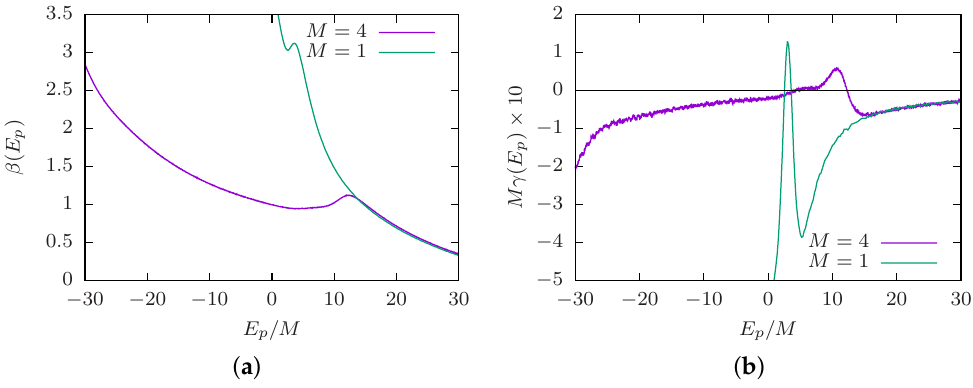
Figure 7. Microcanonical illustration of the competition between single-polymer collapse and many-polymer aggregation on the example of M semiflexible bead-spring polymers ( κ = 4, N = 13) showing ( a ) the microcanonical inverse temperature β ( E p ) and ( b ) its derivative γ ( E p ) . The stiffness was chosen to be stiff enough to yield a first-order-like collapse transition; compare also Figures 1 and 5. Thus, both collapse and aggregation show a back-bending in β ( E p ) and a positive peak in γ ( E p )